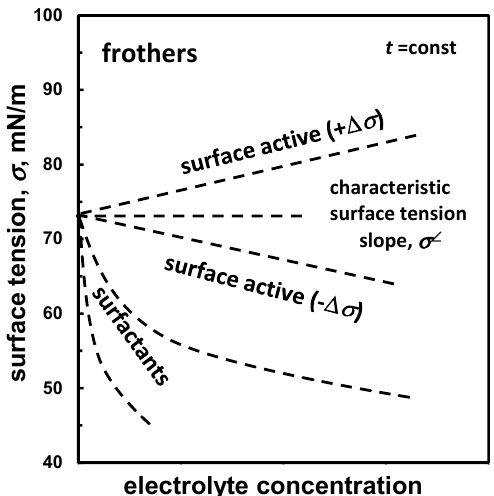
Figure 2. Classification of frothers, based on their ability to change surface tension of water, into surface active with characteristic slope ( σ ∠ ) and surfactants which significantly lower surface tension of aqueous solutions.